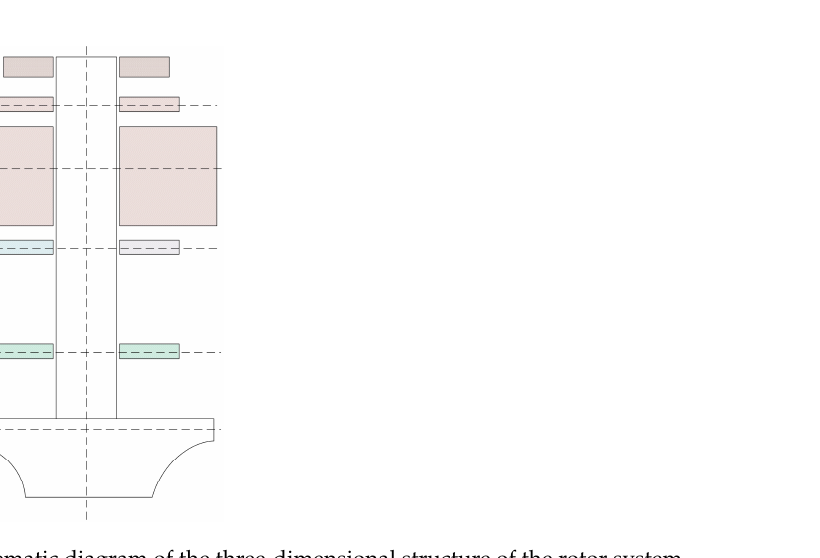
Figure 2. Schematic diagram of the three-dimensional structure of the rotor system. It is assumed that the generator rotor and turbine runner are not deformed during the operation of the unit, while the effect of the torsional action of the main shaft is ignored and the influence of the mass of the rotor shaft and the thrust bearing on the vibration state of the unit system is not considered. The supporting effects of the upper guide bearing, lower guide bearing, water guide bearing, and thrust bearing on the rotor system are modeled separately using the bearing unit as the boundary condition and assuming that the rotating parts are rigid. To simplify the calculations, only the direct stiffness of the oil film is considered, without taking into account the cross stiffness and torsional stiffness.